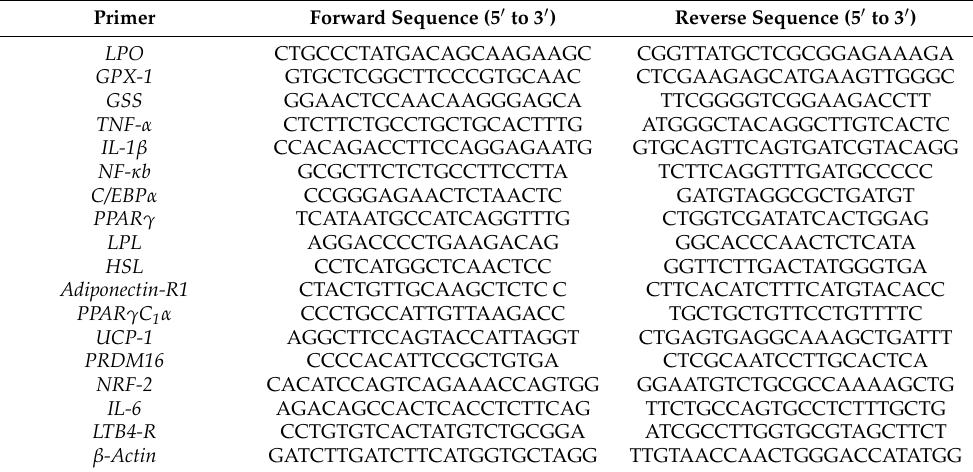
Table 2. Primer sequences used in the sybr-green-based real-time polymerase chain reaction (RT-PCR).